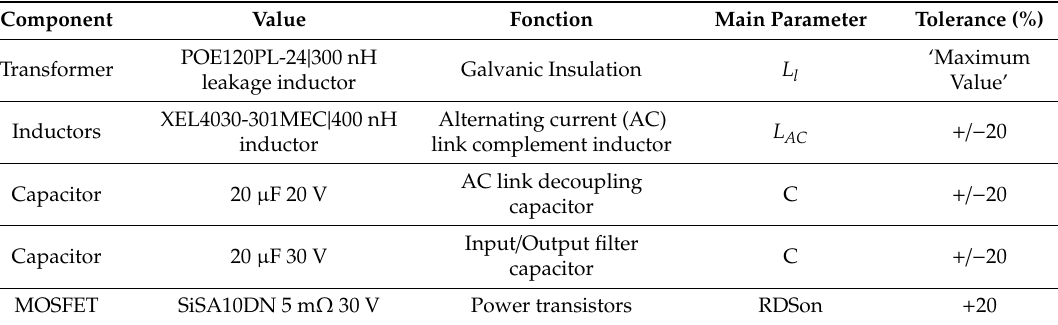
Table 2. DAB converter component list. Includes the main value for the components and their dispersion range, when available.